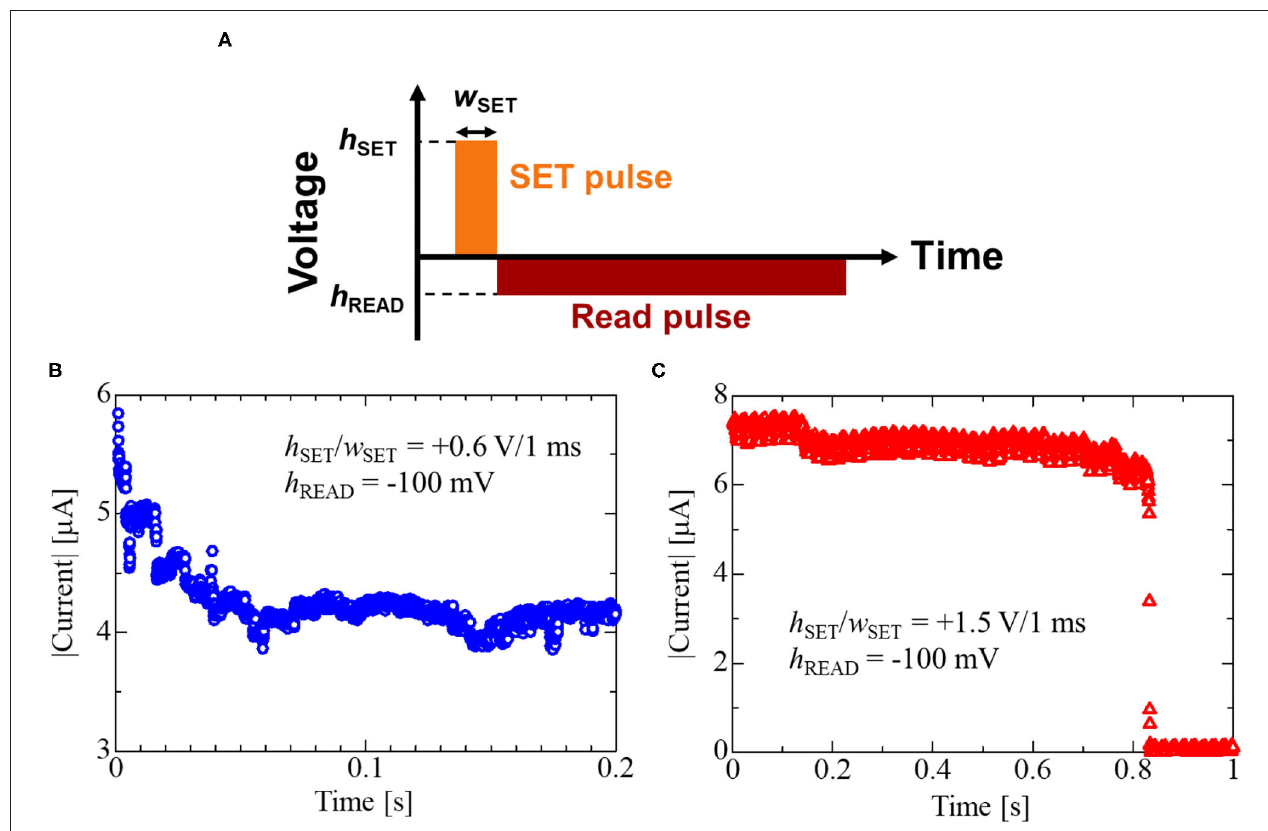
FIGURE 10 | (A) Measurement method for fading characteristics and the results of the fading characteristics of (B) the Cu(II)-IL-Memristor and (C) Cu(I)-IL-Memristor. In (A) , h SET and w SET denote the pulse voltage height and width for the SET pulse, while h READ is the pulse voltage height for the read pulse. The values for h SET , w SET , and h READ used in the present study are specified in (B,C) . The faster fading of the current value was observed in Cu(II)-IL-Memristor compared to